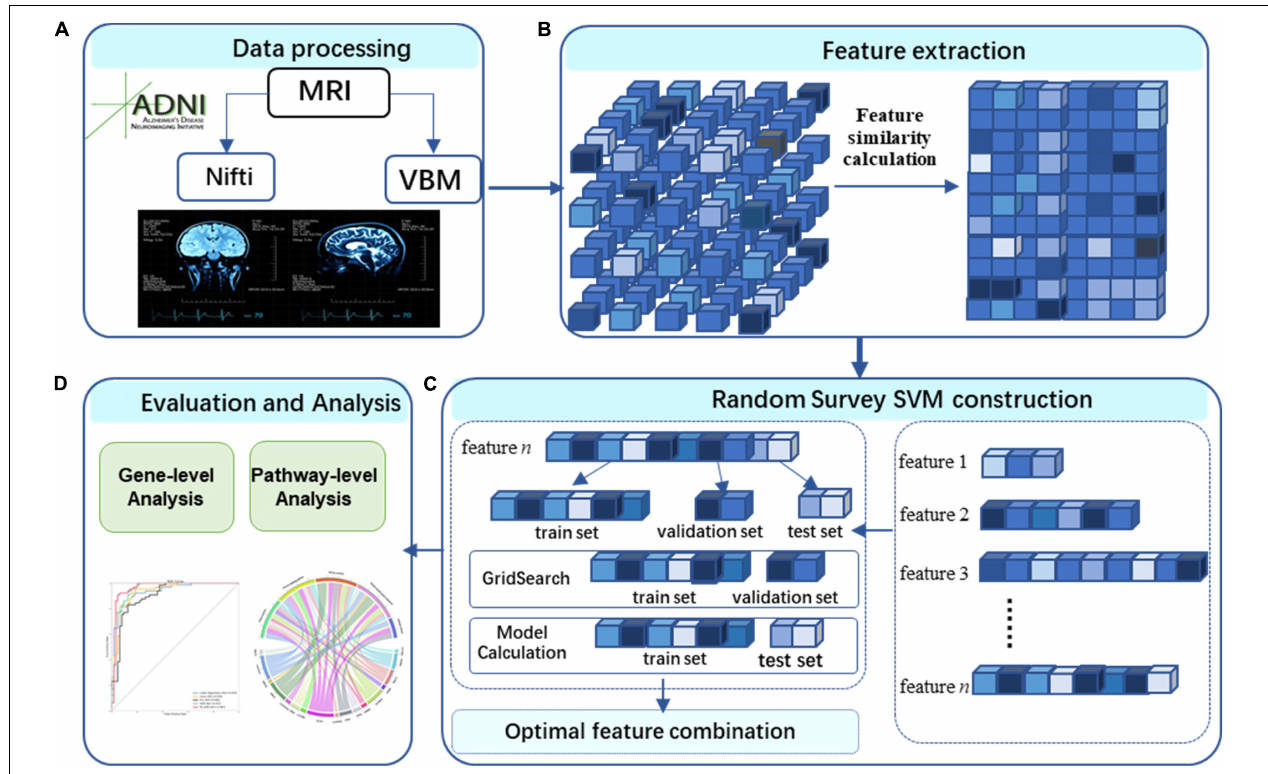
FIGURE 1 | Study workflow. (A) We performed image preprocessing on voxel-based measures extracted from structural MRI (VBM-MRI) in the ADNI data set. (B) Feature extraction. (C) RS- SVM construction. The features were identified by RS-SVM. (D) Evaluation and analysis. We assessed the biological significance using gene- and pathway-level